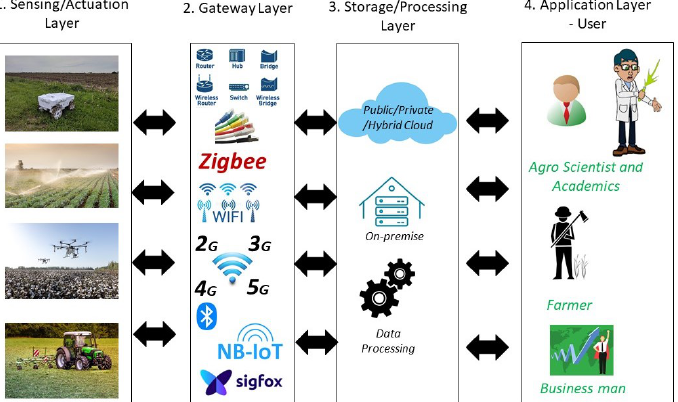
Figure 1. An overview of digital agriculture and its various